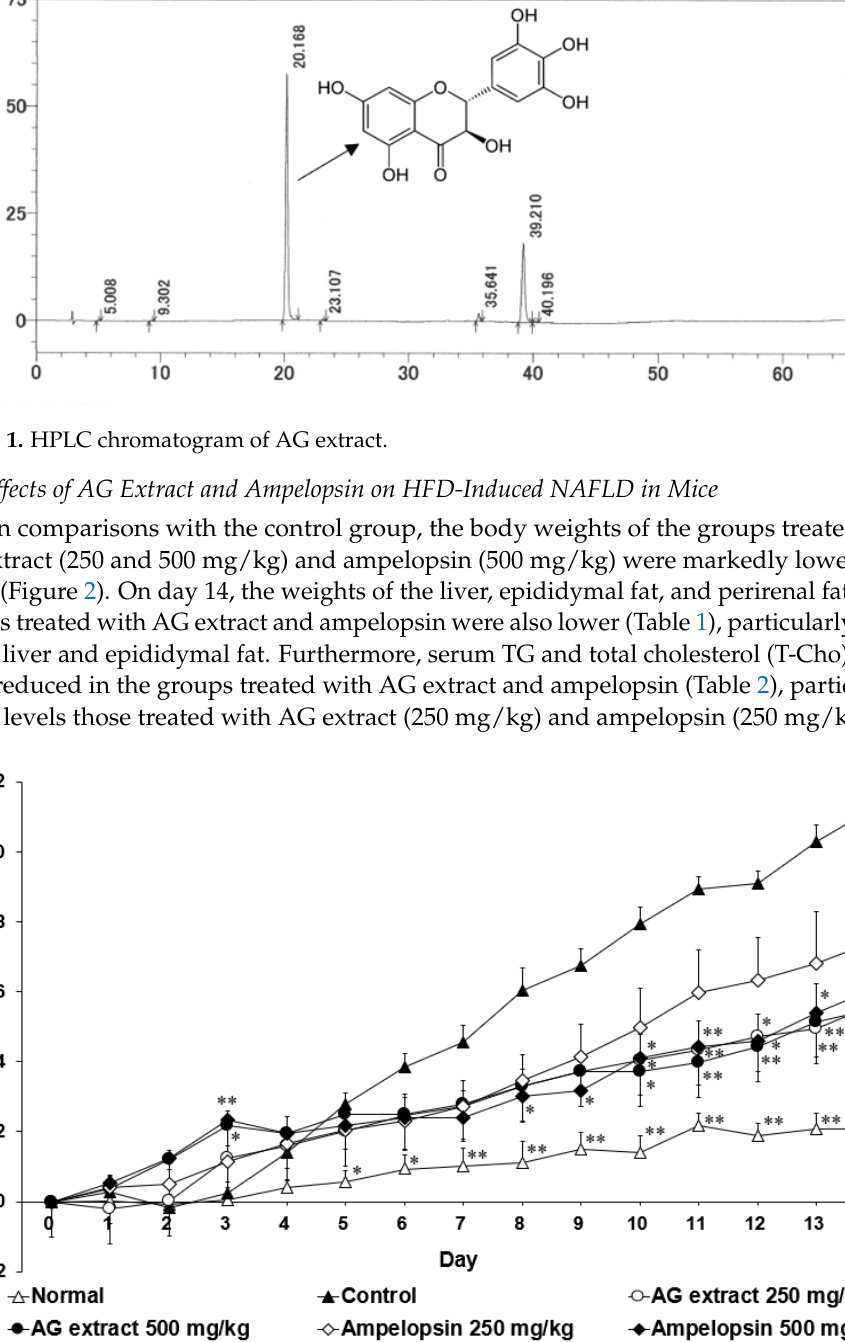
Figure 2. Effects of AG extract and ampelopsin on HFD-induced body weight changes in mice. Each symbol represents the mean ± SE ( n = 7). Data were assessed by a one-way analysis (ANOVA) of variance followed by Dunnett’s method. Asterisks denote significant differences from the control group at * p < 0.05, ** p < 0.01.